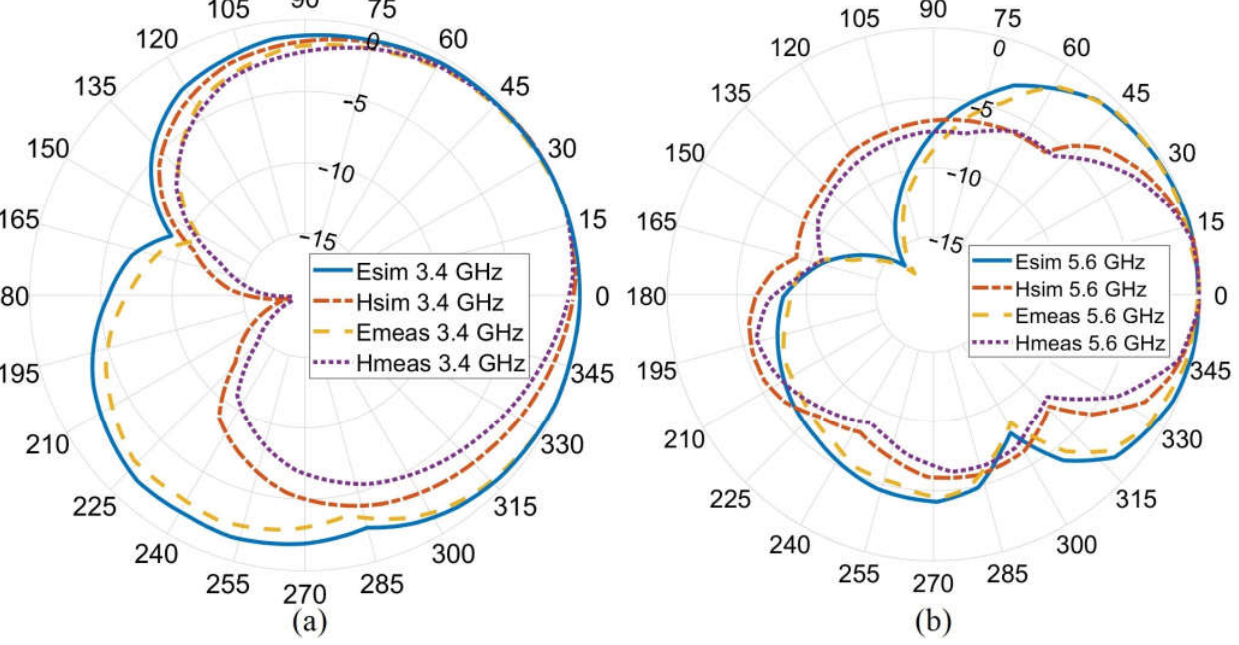
Figure 11. The simulated (sim) and measured (meas) radiation pattern (E-field (XZ plane)/H-field (YZ plane)) of the proposed antenna at ( a ) 3.4 GHz and ( b ) 5.6 GHz.